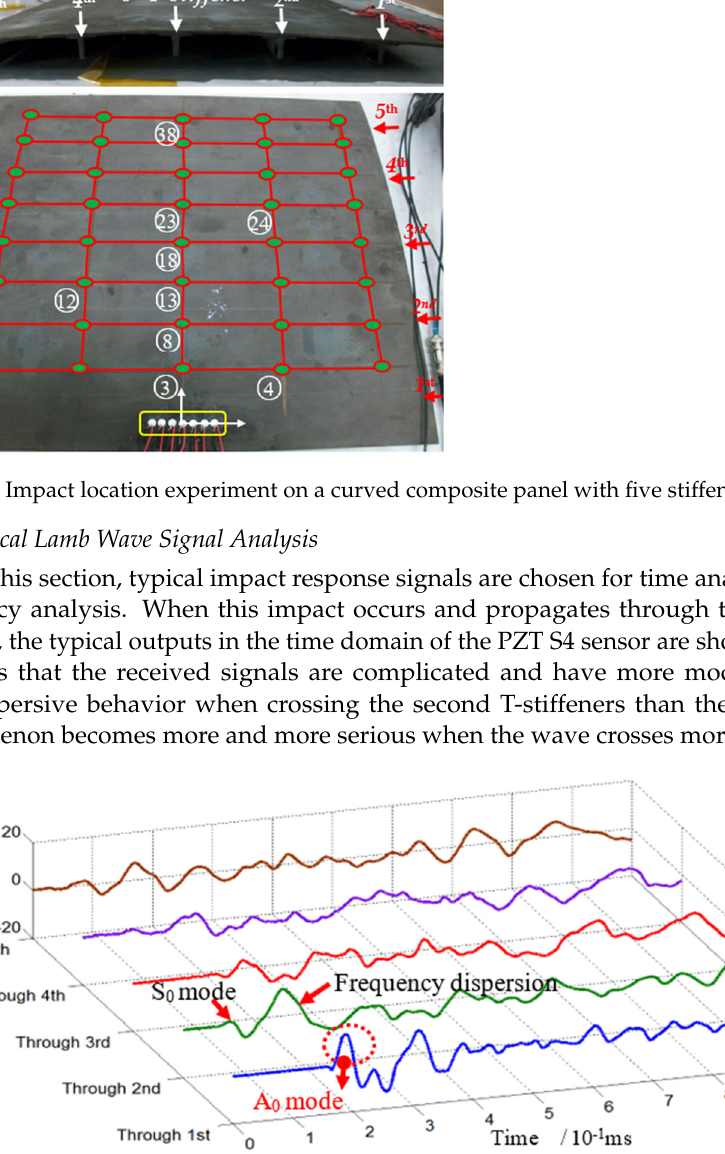
Figure 3. Typical outputs of the PZT sensors when impact signals cross these